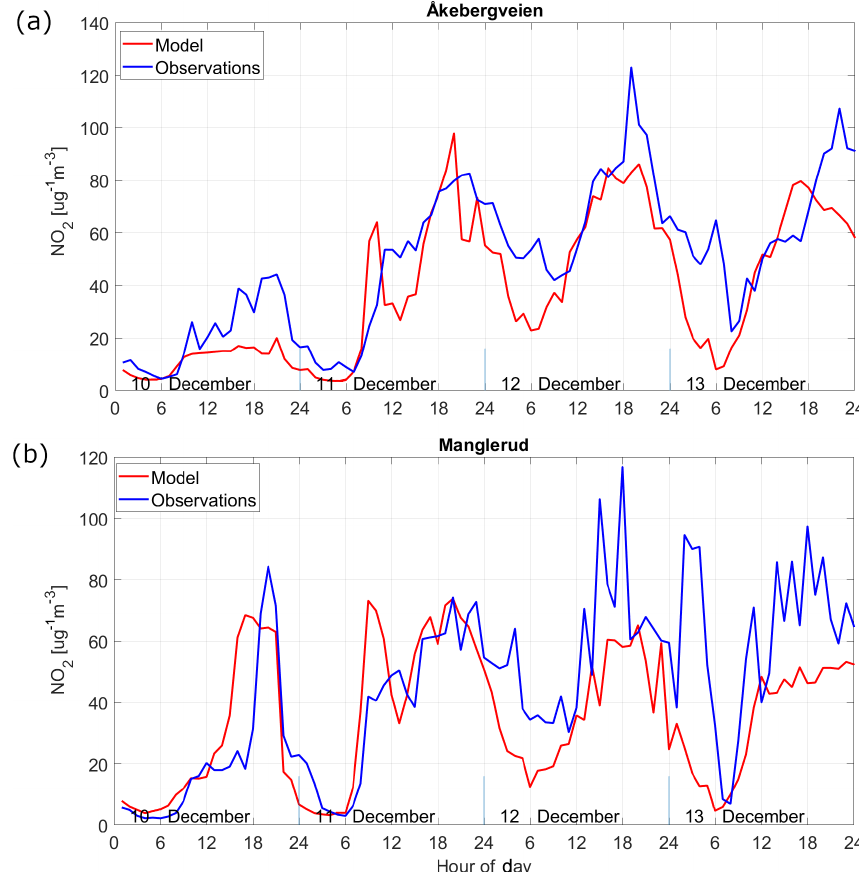
Figure 14. Time series of NO 2 concentrations for the (a) Åkebergveien and (b) Manglerud measuring stations in Oslo during a pollution episode lasting from 10 to 13 December 2015. Receptor point concentrations from the model are shown in red, and the observed concentra- tions are shown in